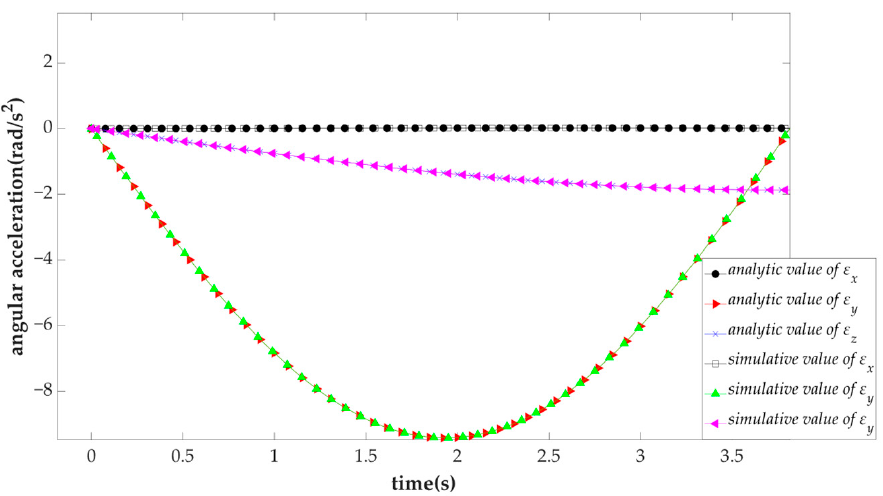
Figure 12. The comparison between analytic results and simulative results of linear acceleration of m .